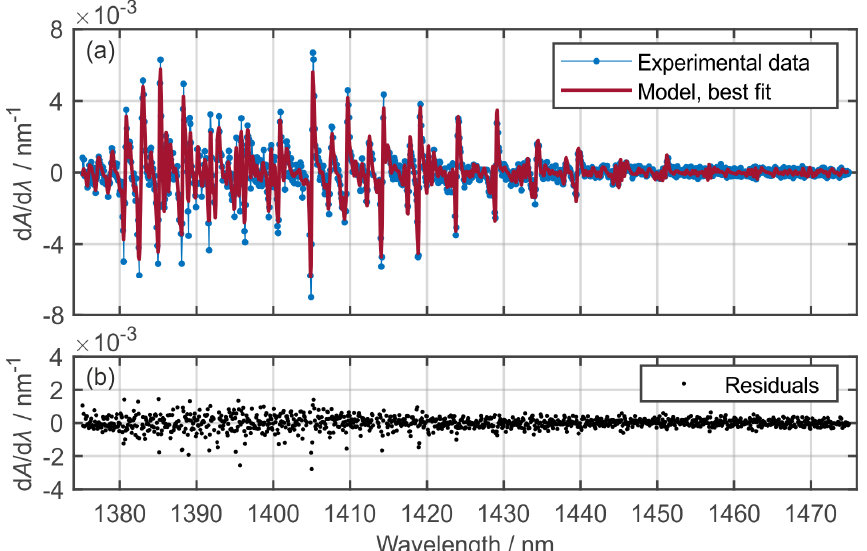
Figure 3. Example for spectra evaluation using NLLSQ curve fitting. ( a ) Best fit for an example dataset (1 vol. % 1-MN mixture consumption resulting in X H2O = 0.25% at p = 1.5 MPa, T = 850 K); ( b ) residuals.